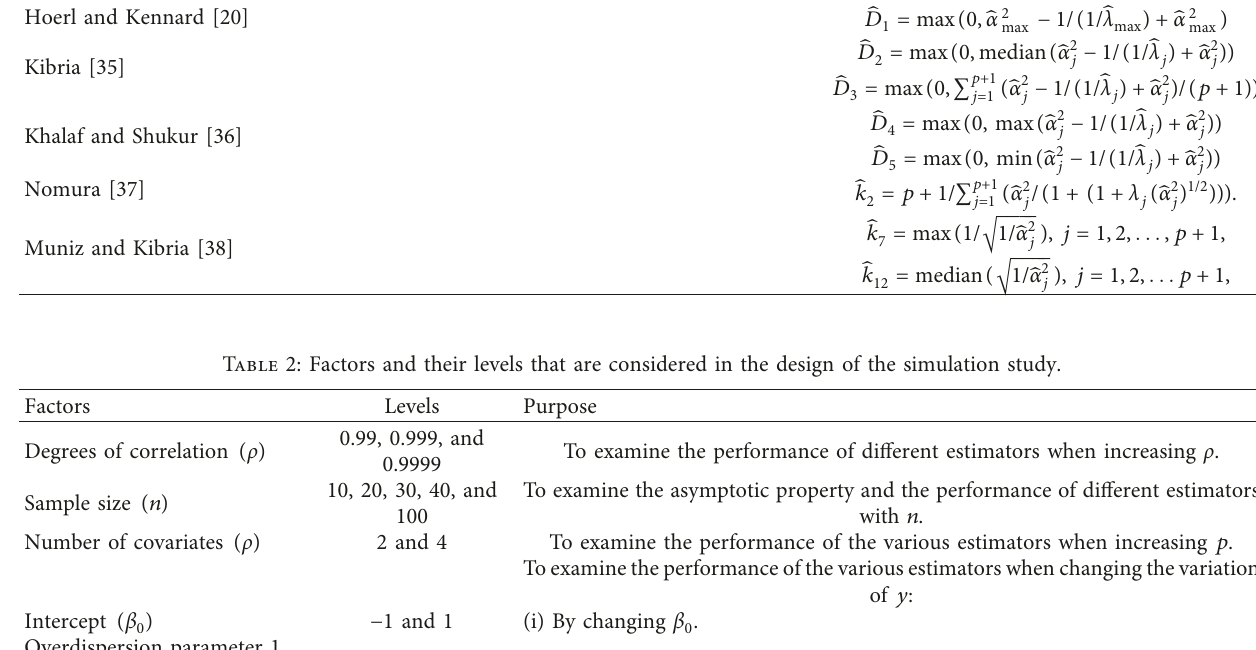
Table 1: The Liu and ridge parameter estimators for the PMQL Liu and ridge regression models. Author(s) Liu and ridge parameter estimators